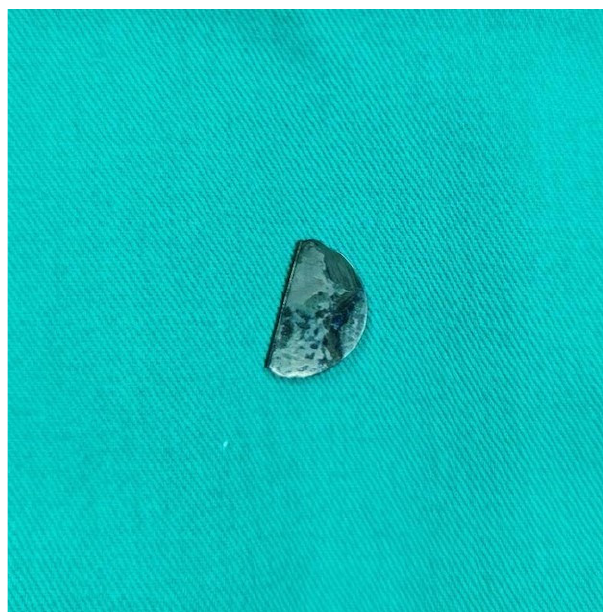
Fig. 2 - Extracted mechanical valve hemidisc.